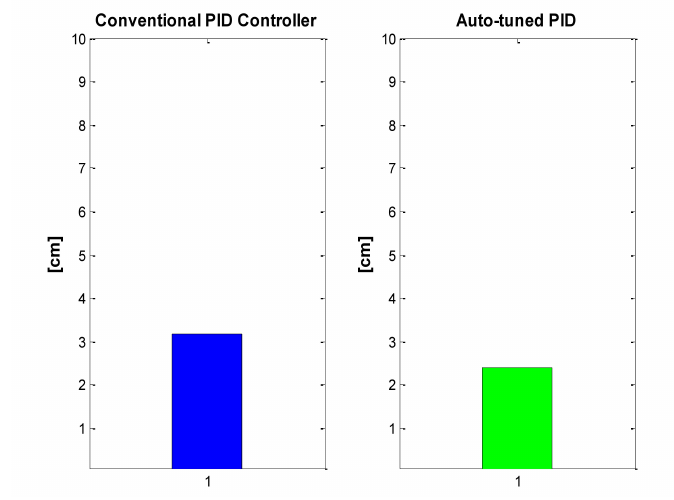
Figure 21. MSE: Conventional PID Controller ( left ) vs. auto-tuned PID ( right